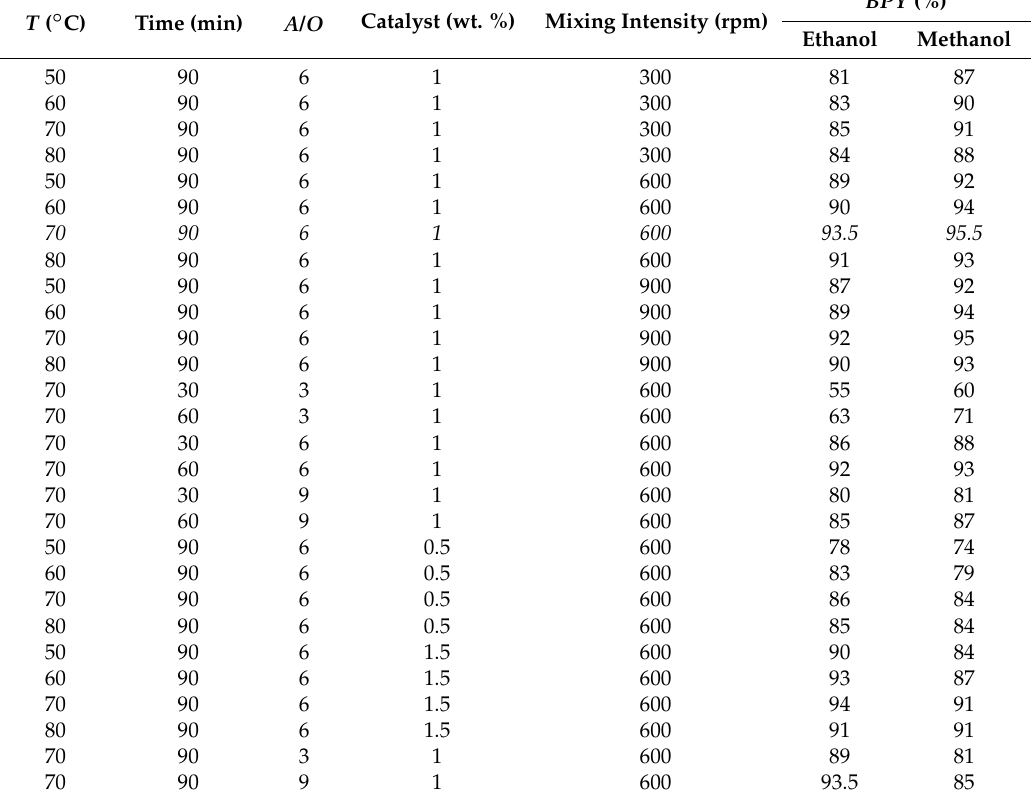
Figure 1. The stages of biodiesel production. Table 1. Data of experimental test and biodiesel production yield ( BPY ) of biodiesel. A / O : alcohol to oil molar ratio.